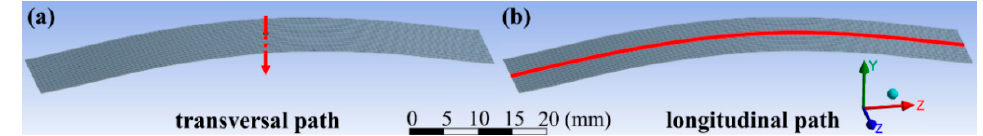
Figure 8. Schematic illustration of the methods for strain distribution analysis in the calculated models: ( a ) transversal path; ( b ) longitudinal path.